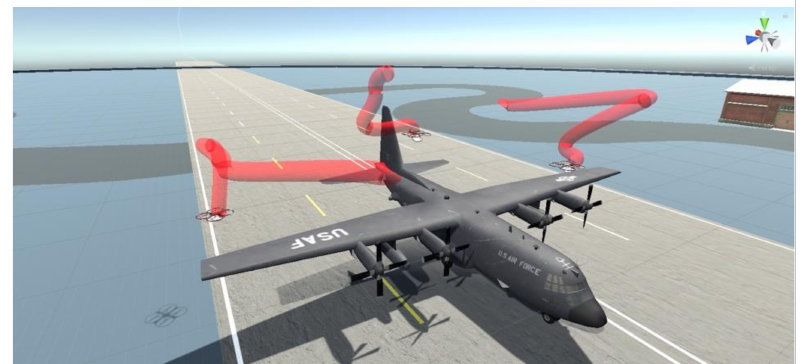
Figure 10. UAV trajectory visualization.